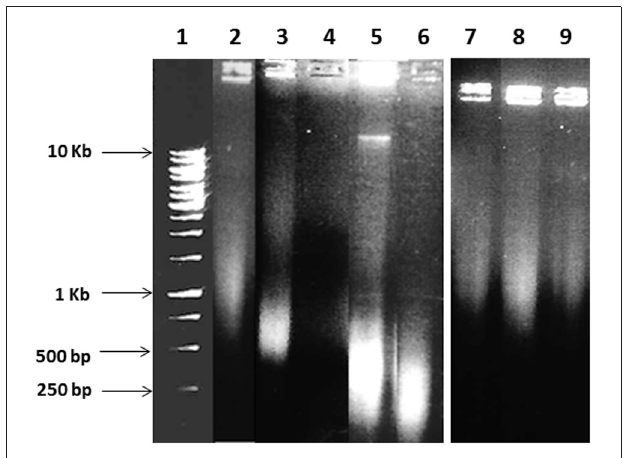
FIGURE A1 | Analysis of degradation of salmon sperm DNA by S. pneumoniae and K. pneumoniae . Salmon sperm DNA (2 μ g) was treated with either bacterial pellet (10 7 cells) or double-filtered supernatant (3 μ l) of S. pneumoniae 19F or K. pneumoniae K15 at 37 ◦ C for 1h in DNase buffer (10mM Tris, 3mM MgCl 2 , 5mM CaCl 2 , pH 7.4), and the reaction was stopped with 0.5M EDTA. The samples were then subjected to 1% agarose gel electrophoresis. Lanes: (1) DNA ladder. Salmon sperm DNA was incubated with (2) DNase buffer; (3) DNA alone; (4) BHI broth; (5) S. pneumoniae pellet; (6) S. pneumoniae supernatant; (7) LB broth; (8) K. pneumoniae pellet; and (9) K. pneumoniae supernatant. The DNA smearing below 500 bp in lanes 5 and 6 revealed that salmon sperm DNA was digested by both pellet and supernatant of S. pneumoniae , indicating secreted DNase activity. However, K. pneumoniae did not digest the DNA as shown by relatively intact salmon sperm DNAs.